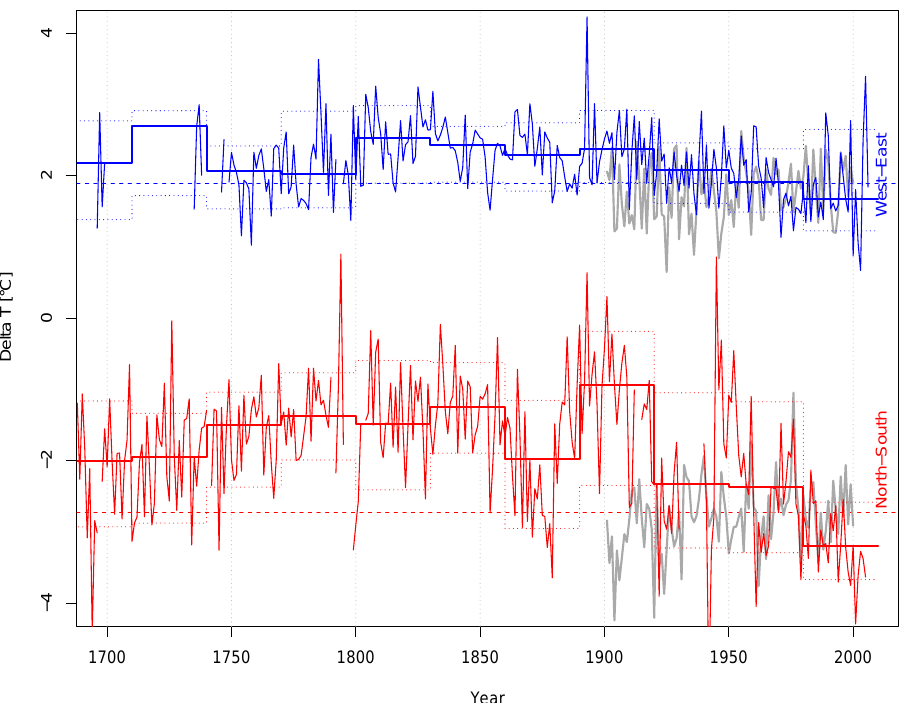
Fig. 3. Differences between North and South (N-S: red line), and West and East (W-E: blue line) reconstructions of mid-March-August temperatures. Colored (red and blue) step lines correspond to 10th, median and 90th quantiles of variations over non overlapping windows of 30yr. Grey lines refer to the April to August temperature differences between Bordeaux and Dijon (W-E), and Paris and Orange (N-S). The horizontal dotted lines represent the mean of the observed temperature